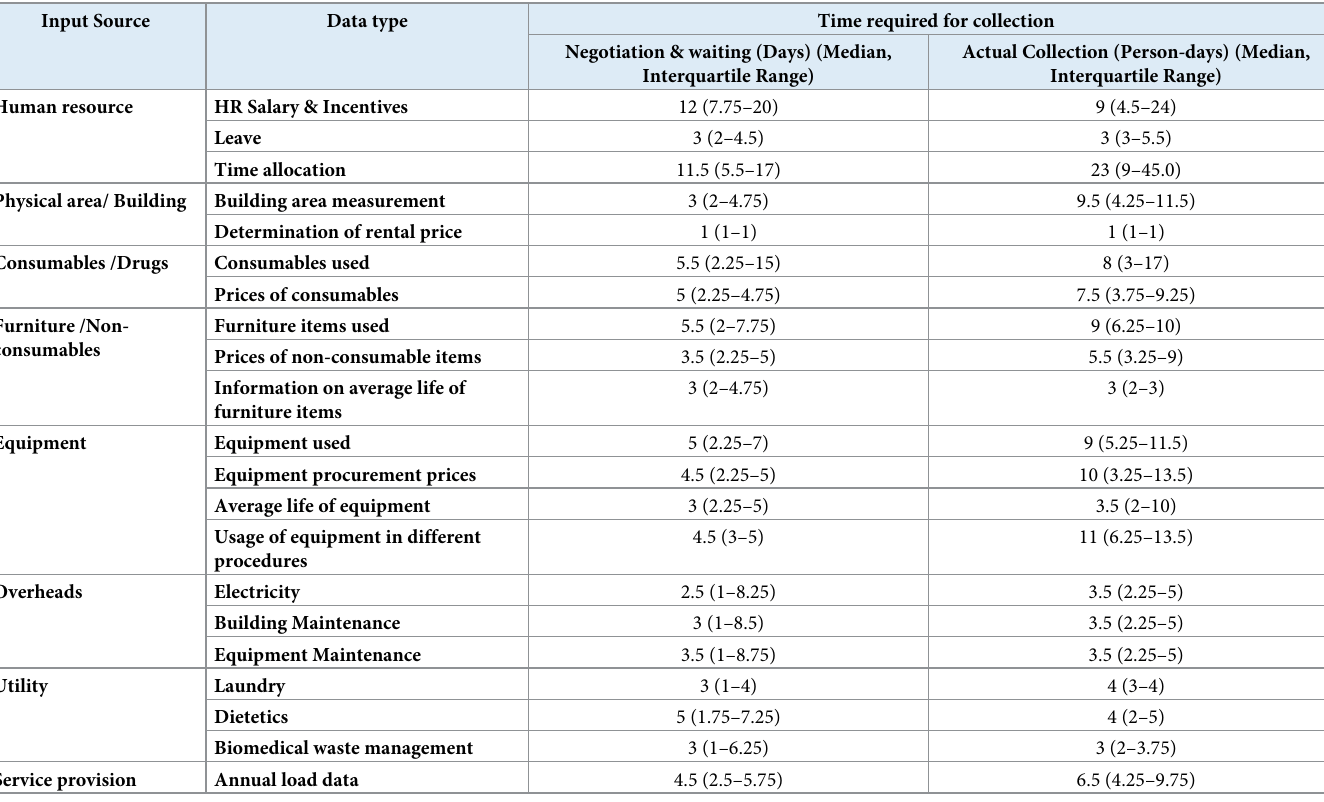
Table 1. Time required for cost data collection for each input resource.